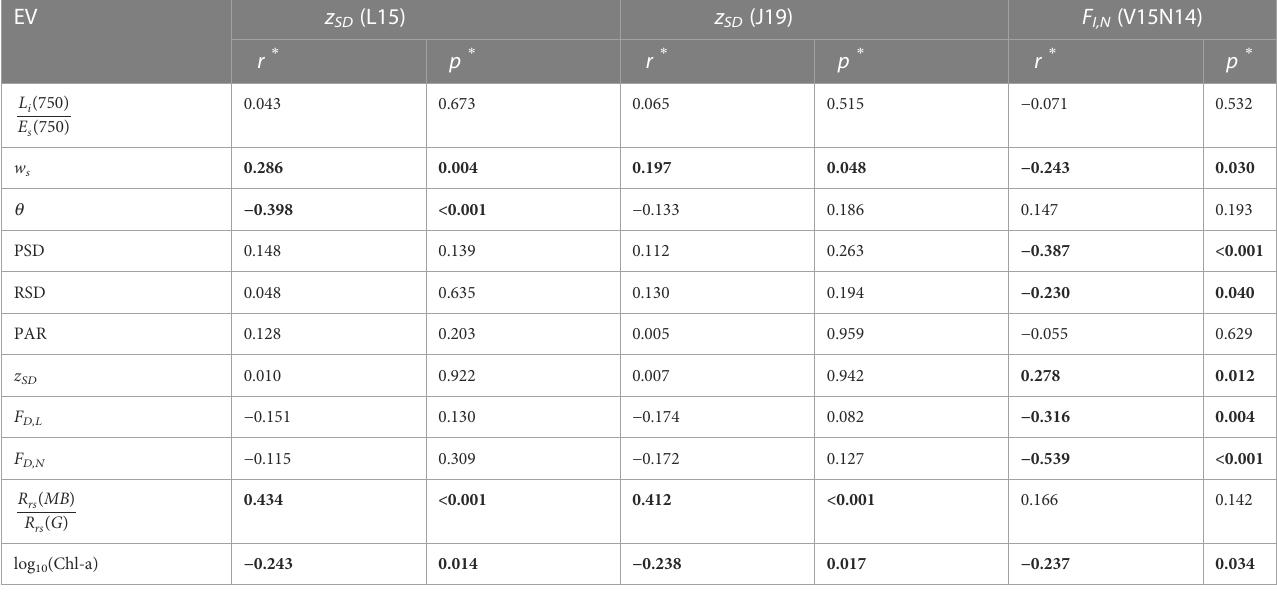
TABLE 5 Residuals between estimated z SD or F using R rs -based models and in-situ data correlated with environmental variables (EV). EV z SD